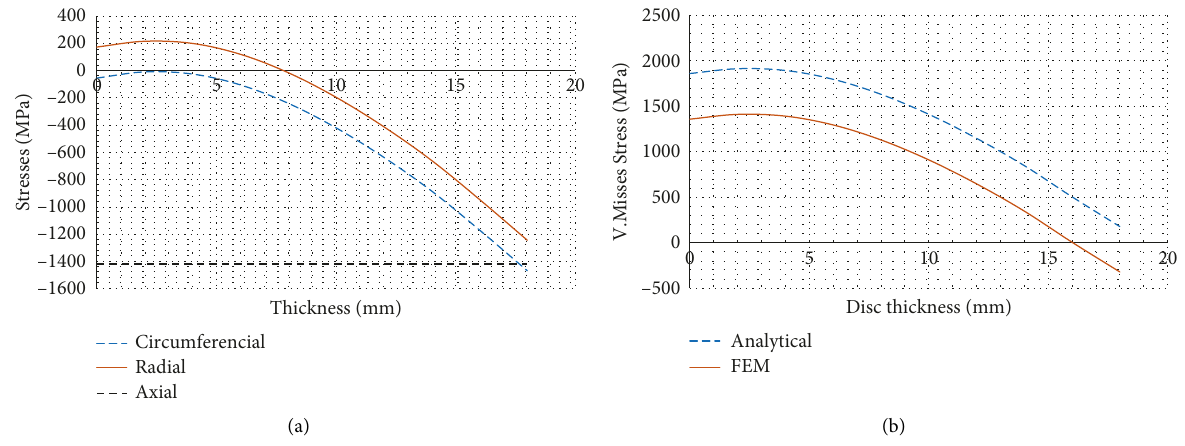
Figure 13: (a) Stress components and (b) von Misses stress distribution within disc brake system.